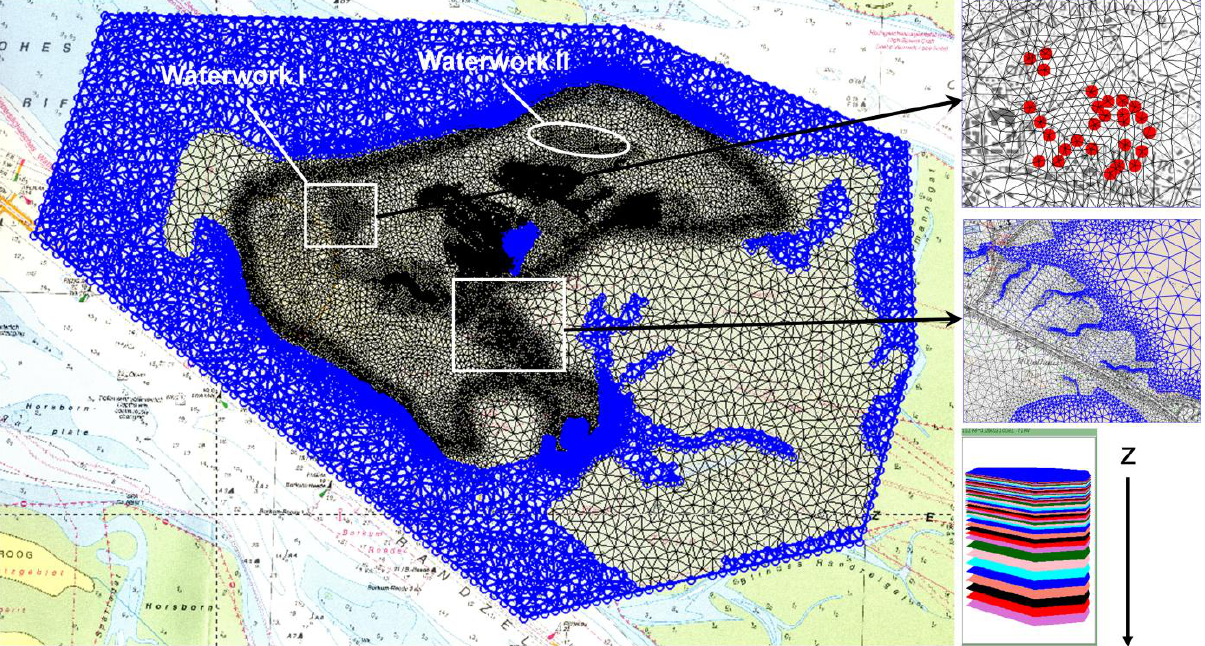
Fig. 9. Setup of the numerical model, left panel: horizontal discretisation and mass transport boundary conditions. The blue marked cells represent sea water boundary conditions at a depth of 1m (TDS=35000mgl − 1 ), right panel: discretisation of model in areas with high complexity. The model consists of 39 superposed horizontal layers, downwards with increasing thickness with depth.